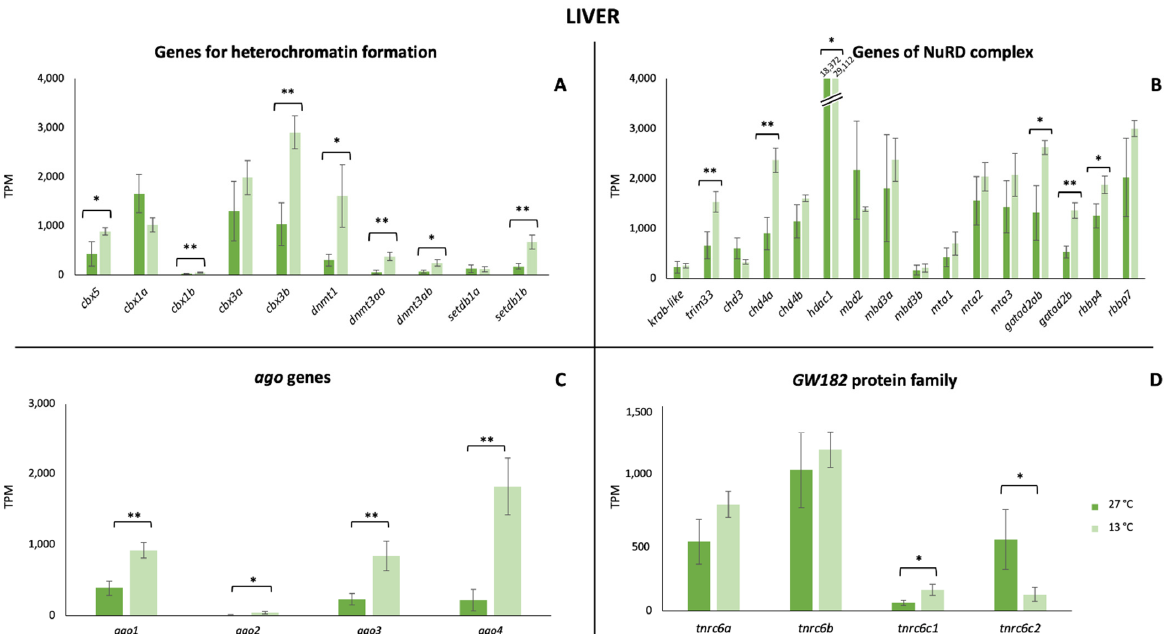
Figure 4. Expression genes involved in TE silencing mechanisms in the liver. ( A ) Expression values of genes encoding for proteins involved in heterochromatin formation. ( B ) Expression values of genes encoding for proteins forming the NuRD complex. ( C ) Expression values of members of the gene subfamily Argonaute . ( D ) Expression values of genes belonging to the GW182 family proteins. Values are reported for both the tested temperature conditions (27 ◦ C and 13 ◦ C). Statistically significant differences are presented as * for p < 0.05 and ** for p <